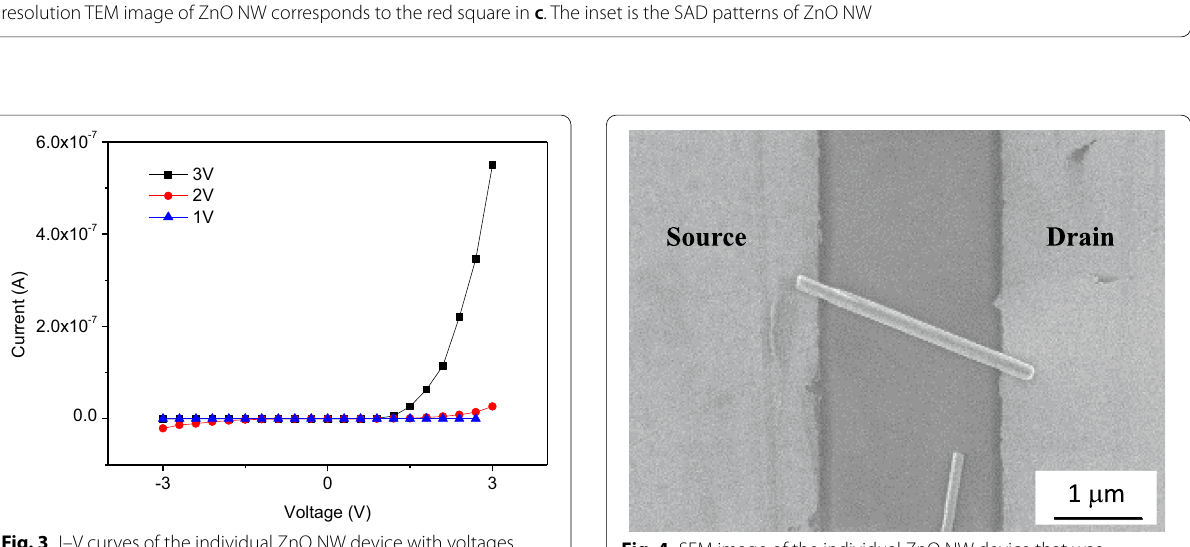
Fig. 5. The crystal structures at the source and drain sides and middle of the nanowire were all the same as that of the ZnO NW before alignment, implying that the alignment